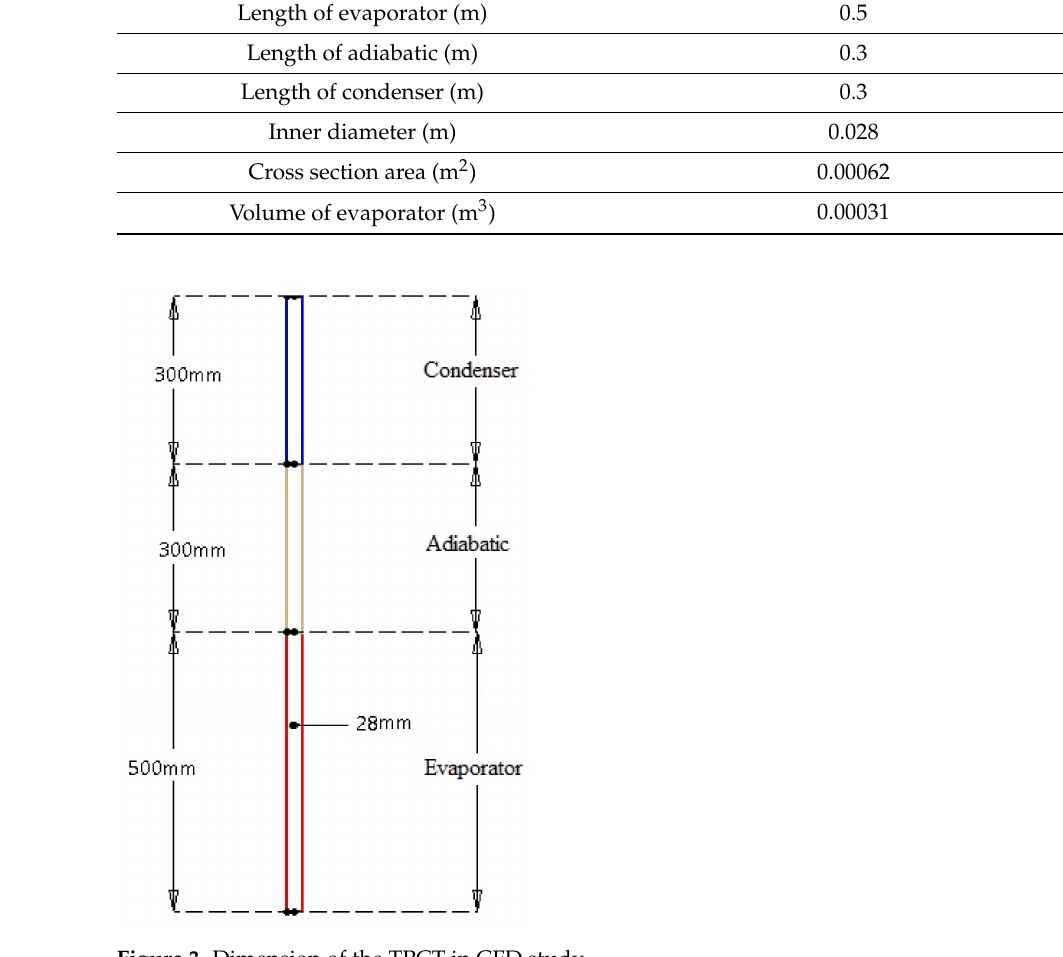
Figure 3. Dimension of the TPCT in CFD study.